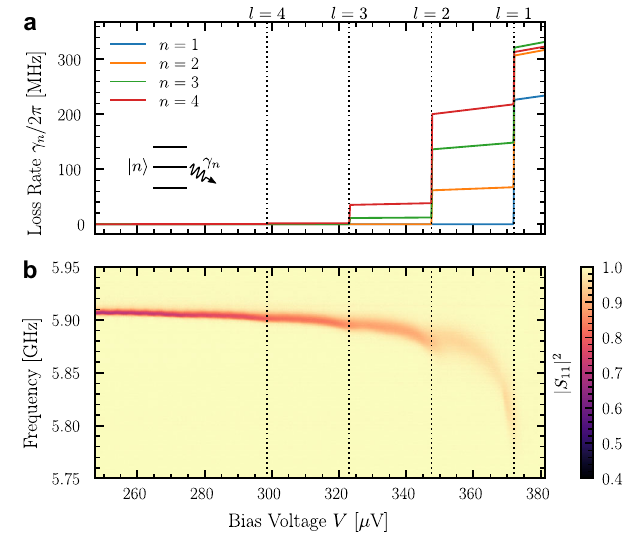
Fig. 2 | Tunnel junction as a tunable quantum absorber. a Quasiparticle tun- nelinginducesanextraloss γ n (Eq.(2)),whichisdifferentforeachFockstateofthe modecoupledtothejunction.Dashed verticallinesshowtheonsetof the l photon absorption process, given by (2 Δ − l ℏ ω )/ e . The photon number n corresponding to the lowest Fock state with increased loss can be chosen with the bias voltage. The parameters correspond to the ones expected in the experiment. b Experimental spectroscopy of the 6GHz mode as a function of the bias voltage V . The image shows the measured re fl ection coef fi cient ∣ S 11 ∣ 2 for an incident power of − 115dBm on the resonator. The onset of the different absorption processes is clearly visible up to l